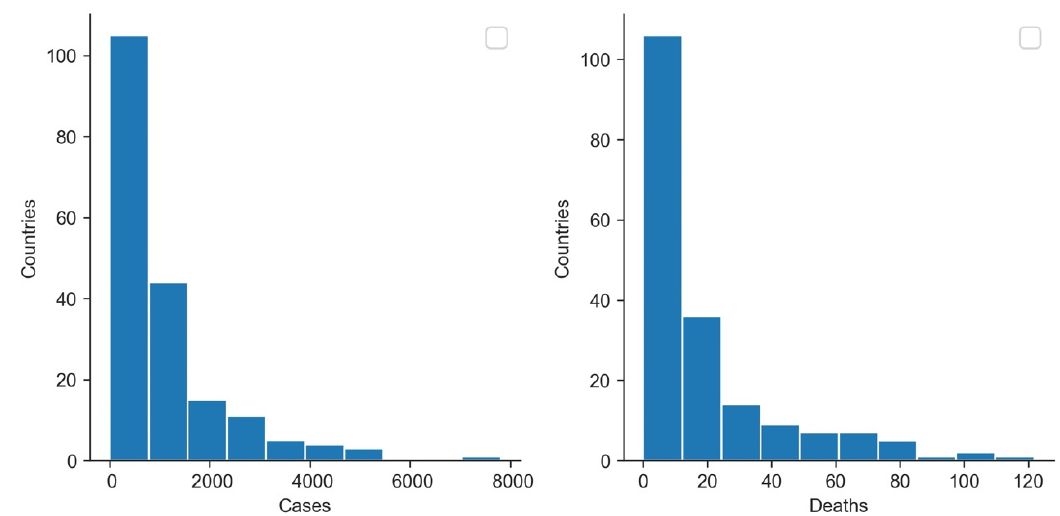
Figure 14. Cases vs. deaths: Histograms for total cases and deaths per 100,000 of the population at Day 250.